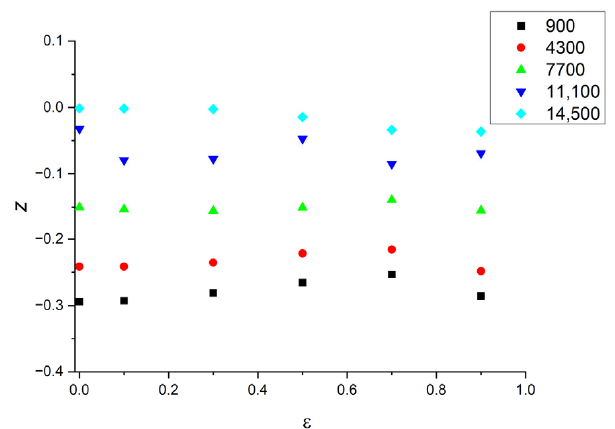
Figure 5. Inlet loss factor ( z ) of ring seal.